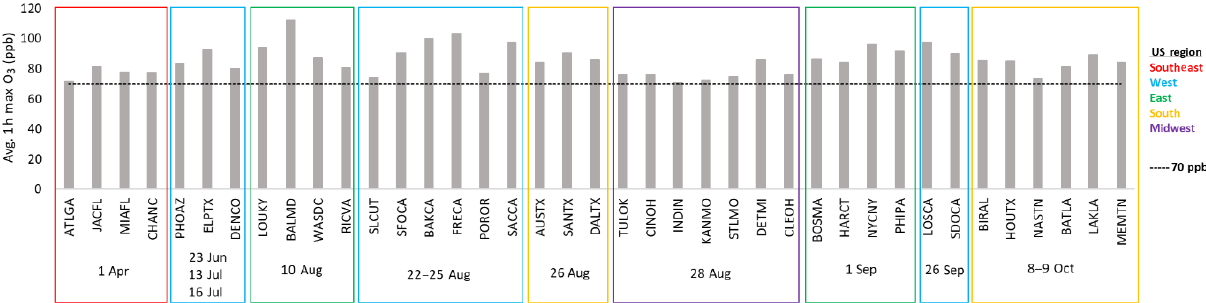
Figure 2. Average 1h maximum O 3 across all monitors in each domain. Cities are grouped by corresponding extreme O 3 dates (that averaged > 70ppb) and US geographical